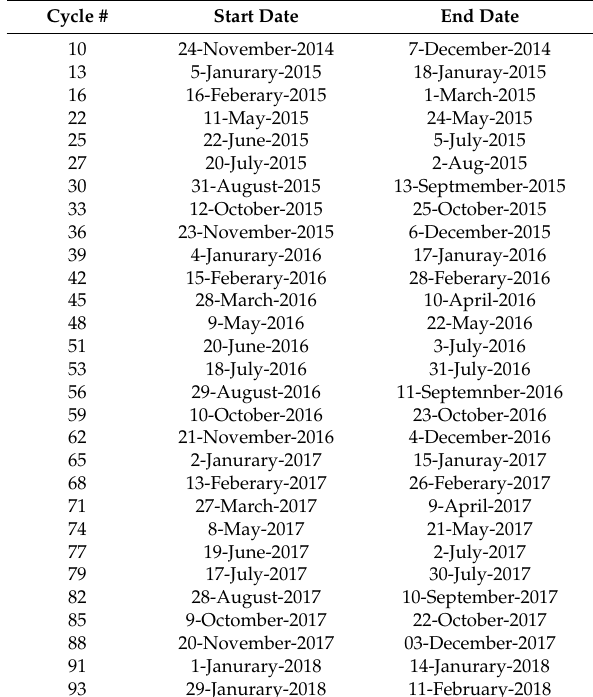
Table A1. ALOS2 PALSAR-2 ScanSAR mosaic observation date ranges for each cycle.